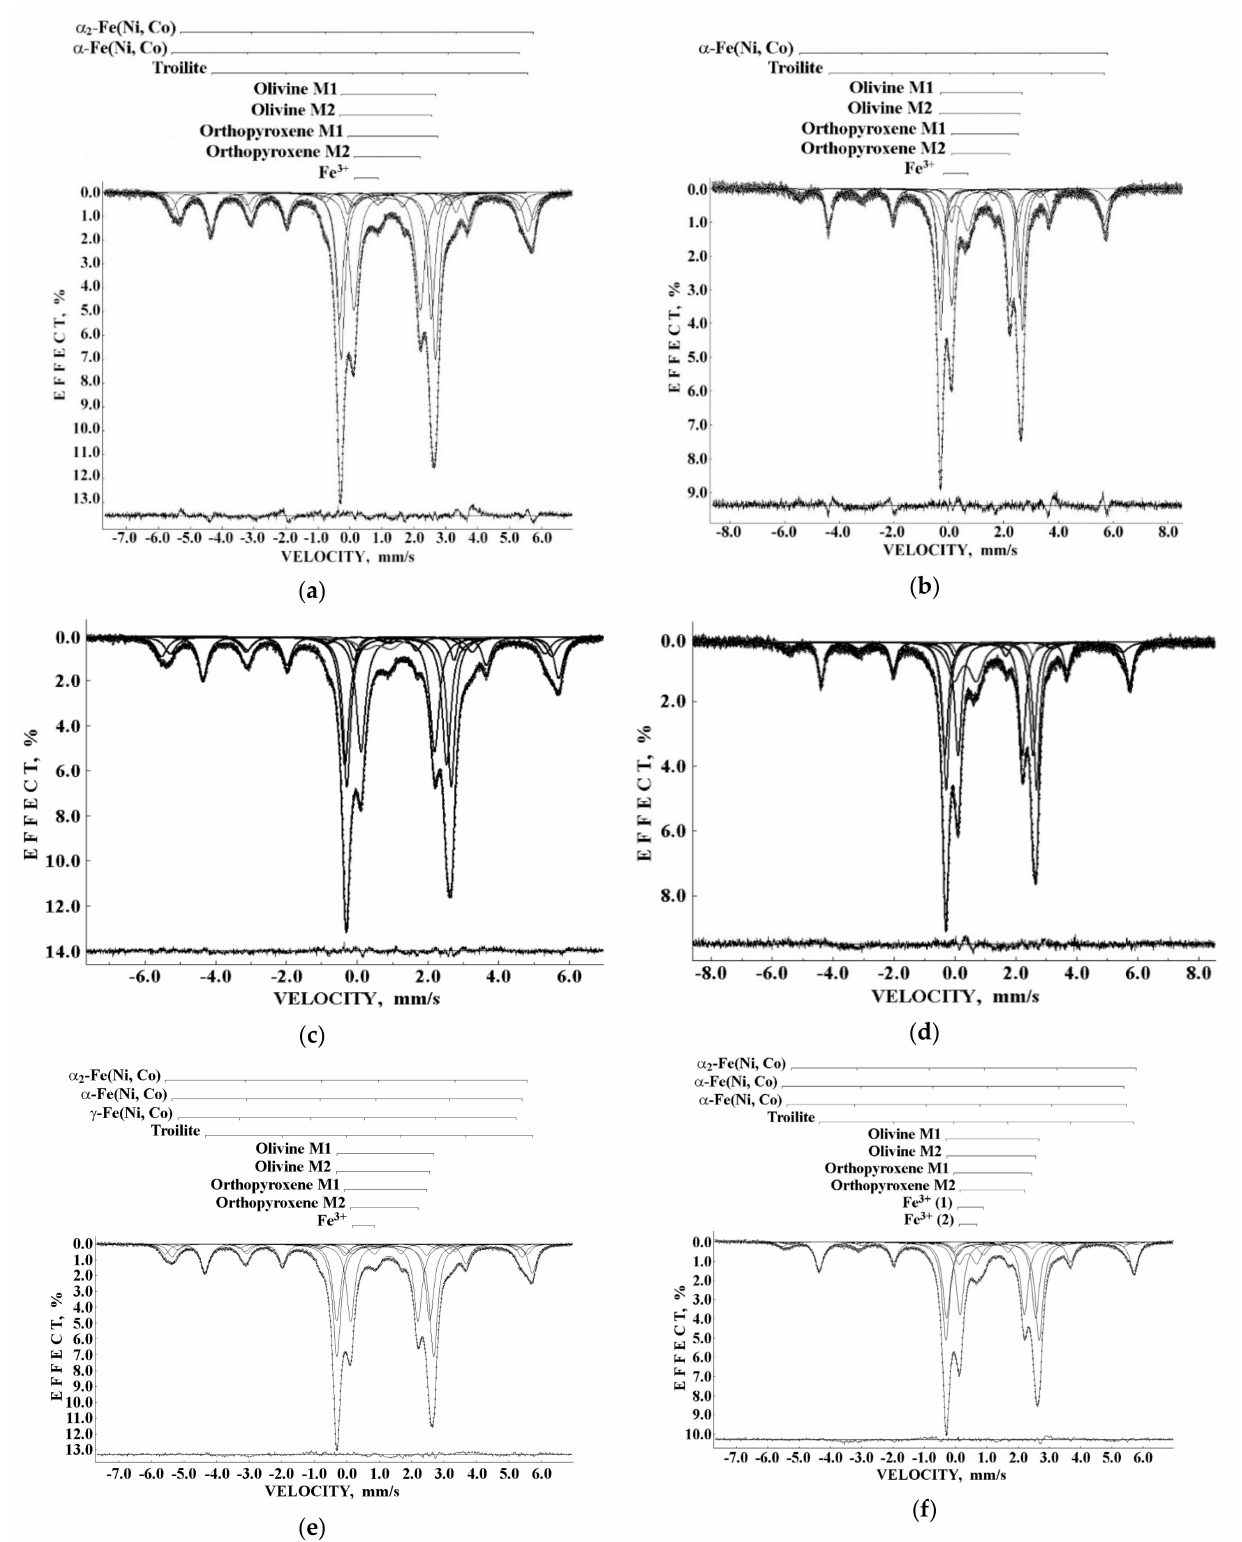
Figure 27. Comparison of the fits of the room temperature Mössbauer spectra of equilibrated ordinary chondrites Farmington L5 ( a , c , e ) and Tsarev L5 ( b , d , f ): using perturbation of the first order for troilite component ( a , b ), using the full static Hamiltonian for troilite component ( c , d ) and using simulation of the full static Hamiltonian for troilite component ( e , f ). The Mössbauer spectra ( a – d ) are presented in 2048 channels while the spectra ( e , f ) are presented in 1024 channels. The differential spectra are shown on the bottom. Adapted from Reference